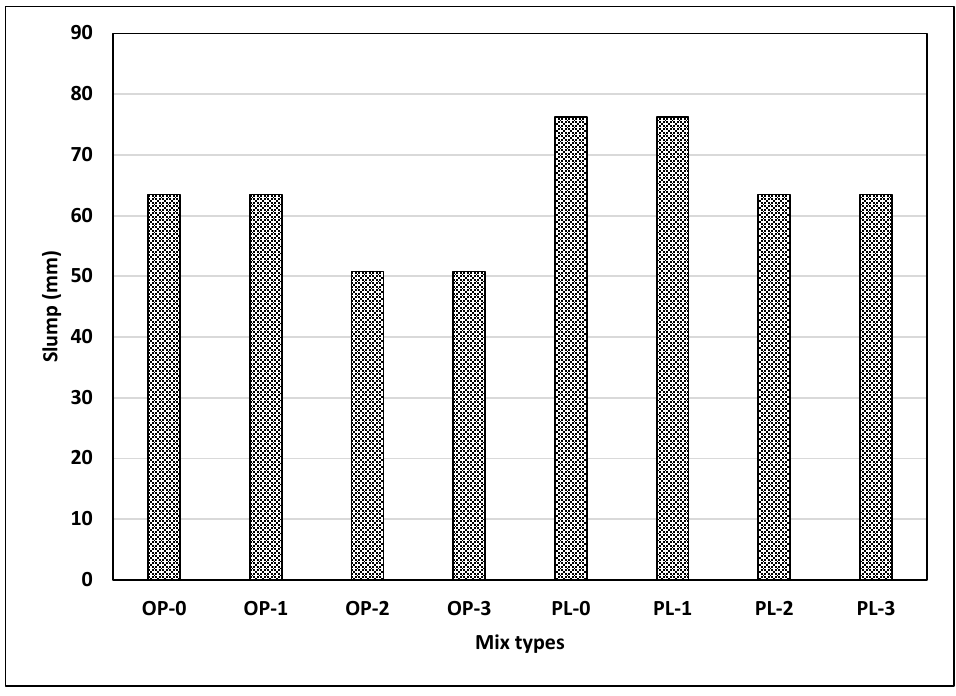
Figure 4. Results of slump test for all mixes.